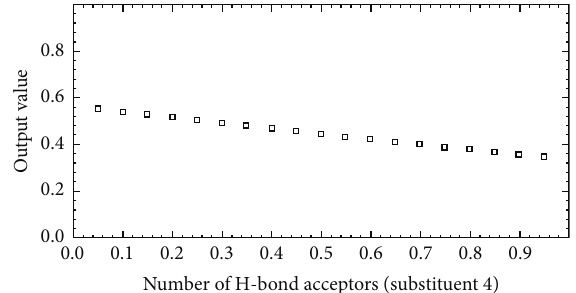
4)0.0 Number of H-bond acceptors (substituent Figure 9: Dependency graph illustrating the correlation between number of H-bond acceptors (substituent 4) used to train the neural network architecture versus the actual activity